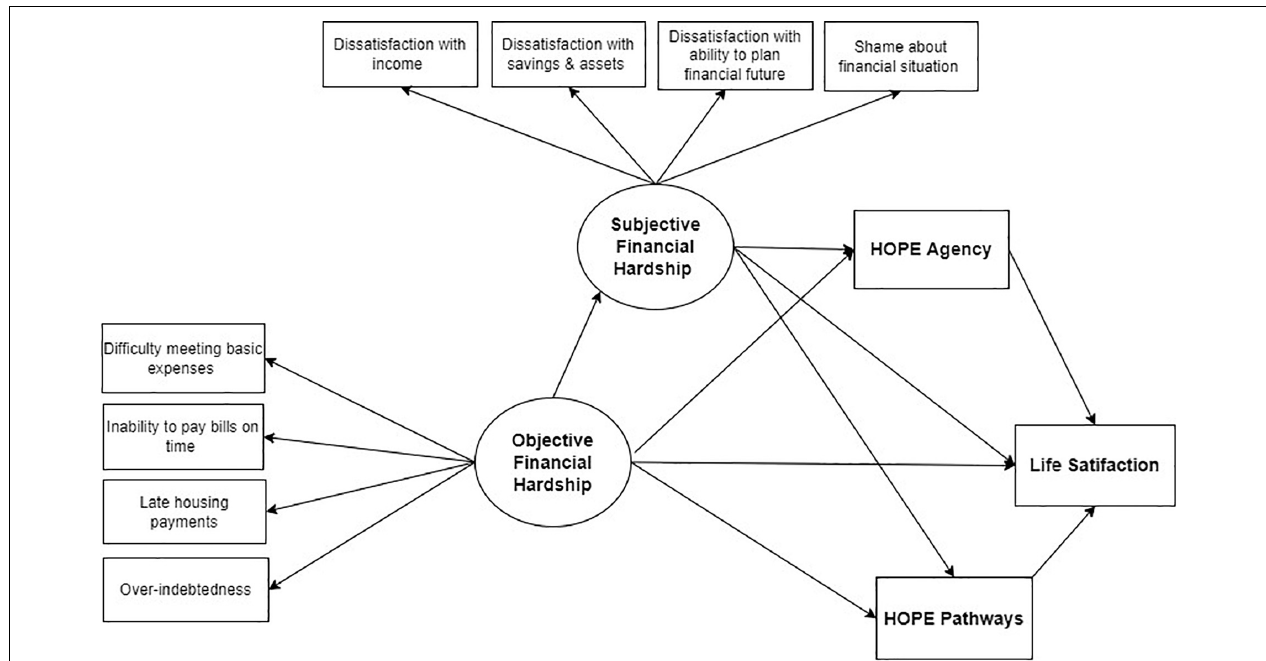
FIGURE 1 | Hypothesized relationships between objective financial hardship (OFH), subjective financial hardship (SFH), hope agency, hope pathways, and life satisfaction